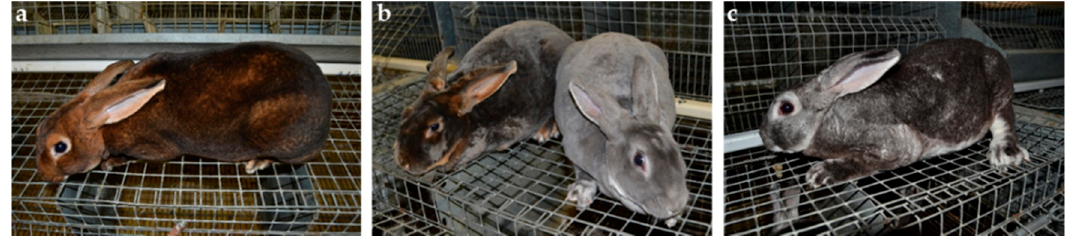
Figure 1. Characterization of the dilution phenotype in Castor and Chinchilla breeds. The rabbits with a wild type (wt) coat color are shown for the ( a ) Castor and ( c ) Chinchilla breeds. The picture ( b ) represent Castor (left) and Chinchilla (right) diluted animals.